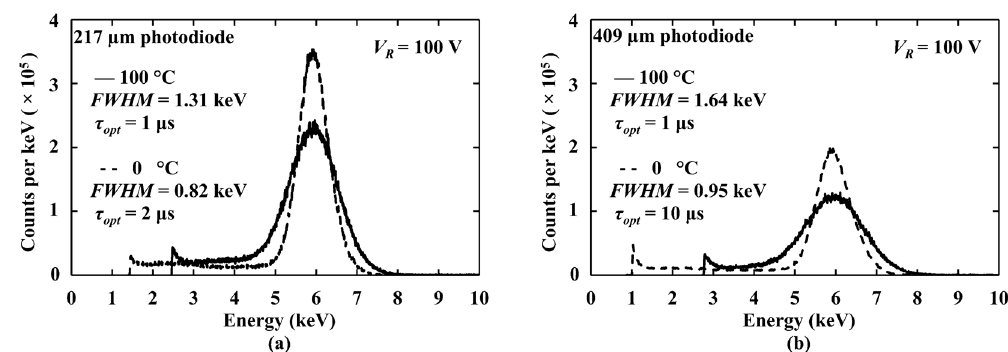
Figure 4. 55 Fe X-ray spectrum obtained with ( a ) 217 µ m diameter photodiode and ( b ) 409 µ m diameter photodiode at 100 V reverse bias, at a temperature of 100 °C (solid line) and 0 °C (dashed line), at the optimum shaping